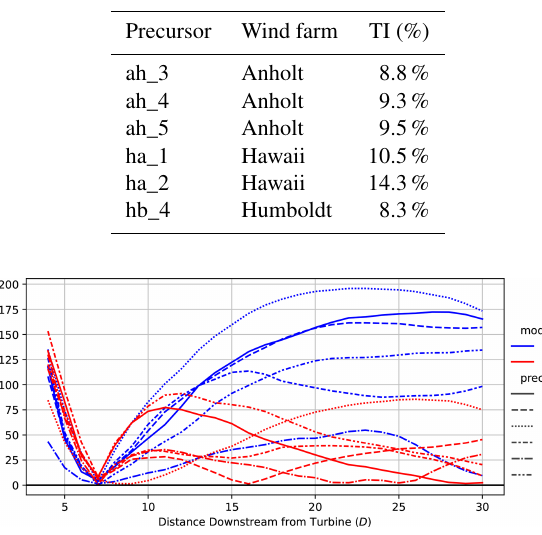
Figure 2. Absolute error between FLORIS and SOWFA predictions for the single-turbine wake-recovery characterization. The figure shows that the error has significantly decreased with the CC model compared to the GCH model, notably for the far